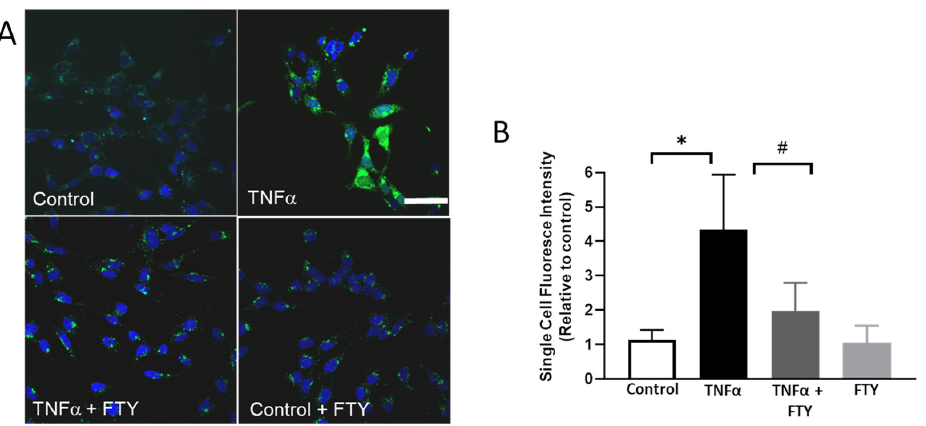
Figure 5. Fingolimod reduced TNF α -induced ROS formation. ( A ) Representative images showing the impact of FTY on reactive oxygen species (ROS) formation. H2DCFDA (DCF) assay was used to assess the generation of ROS. Scale bar 50 µm. ( B ) Quantification of single cell fluorescence intensity showing of the increased ROS formation in response to TNF α treatment, which was reduced in the presence of FTY [* p < 0.01 vs. control; # p < 0.01 vs. TNF α , n = 3 per group].